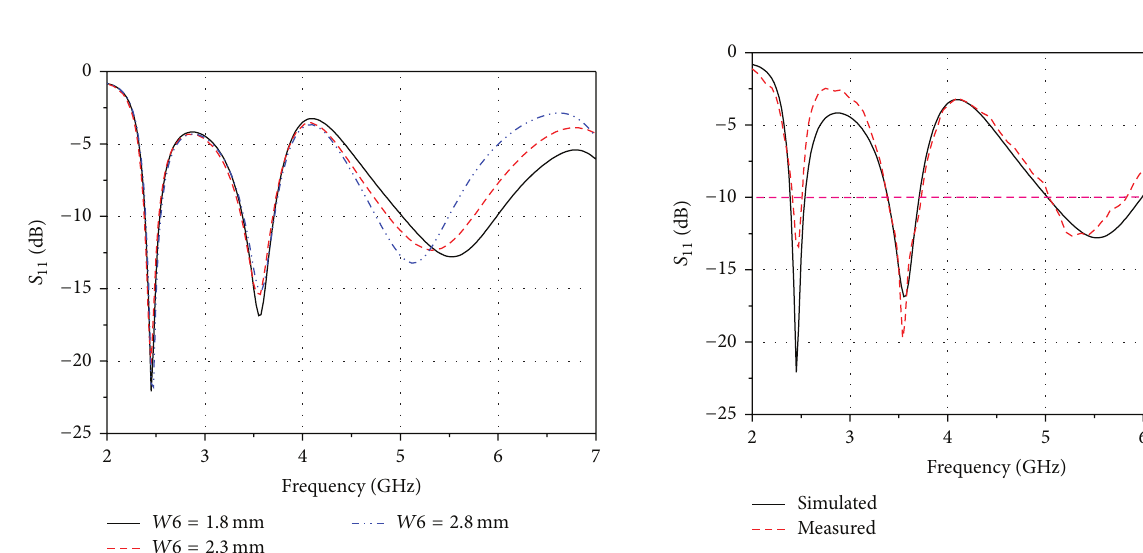
Figure 3: Effects of the parameter 𝐿2 on the return loss.